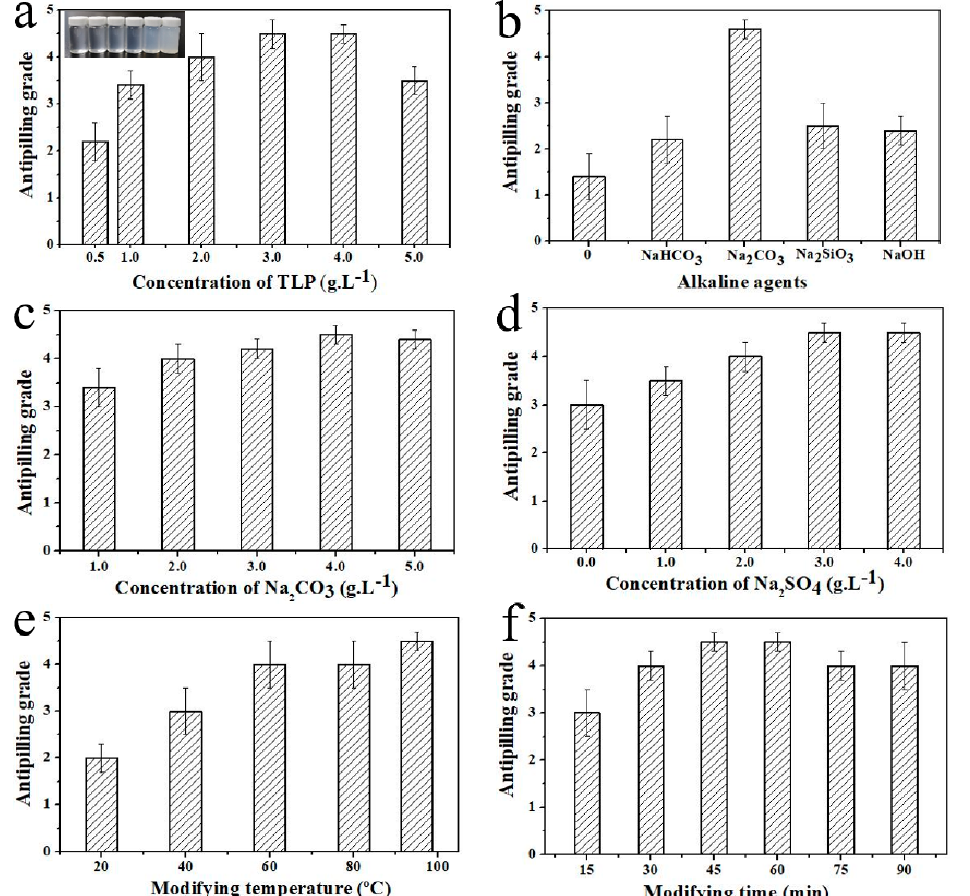
Figure 3. Effect factors in the TLP modification process on antipilling grade of TLP-modified cotton fabric. ( a ) concentration of TLP dispersions; ( b ) kinds of alkaline agents; ( c ) concentration of Na 2 CO 3 ; ( d ) concentration of Na 2 SO 4 ; ( e ) modification temperature; ( f ) modification time.